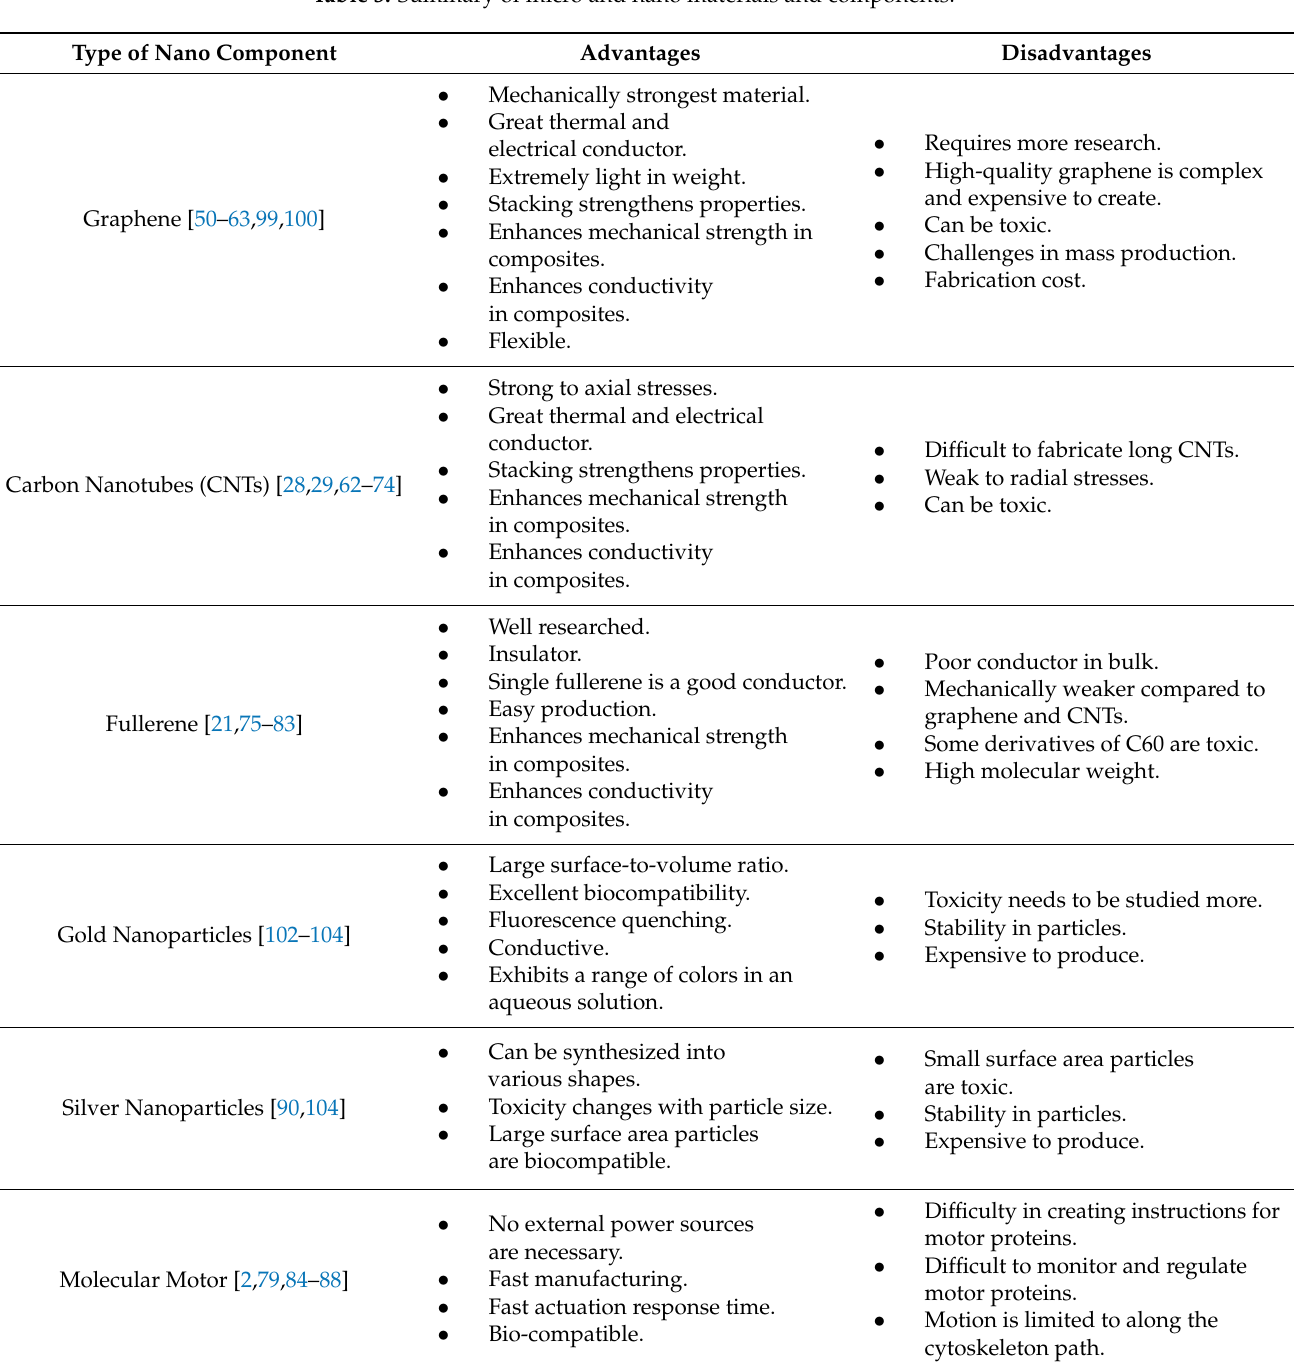
Table 3. Summary of micro and nano materials and